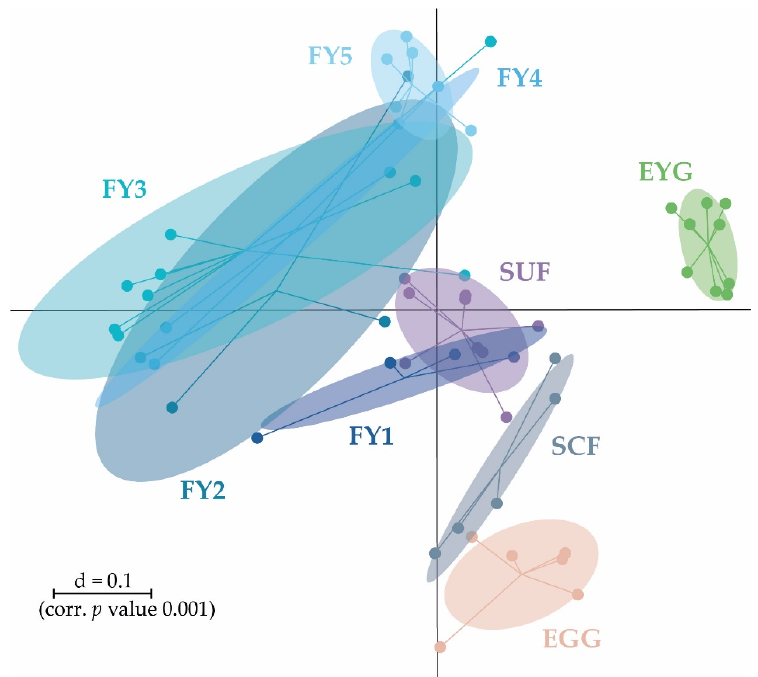
Figure 2. β -diversity of all samples shown as a multidimensional-scaling (MDS) plot. The scale is an indicator for the variation in the taxonomic makeup of microbiota between samples ( β -diversity) based on generalized UniFrac distances (d = 0.1 marks a 10% difference). EGG, egg; EYG, eyed egg; SCF, sac fry; SUF, swim-up fry; FY1, fry 69 dpf; FY2, fry 74 dpf; FY3, fry 82 dpf; FY4, fry 88 dpf; FY5, fry 95 dpf; dpf, days post fertilization.